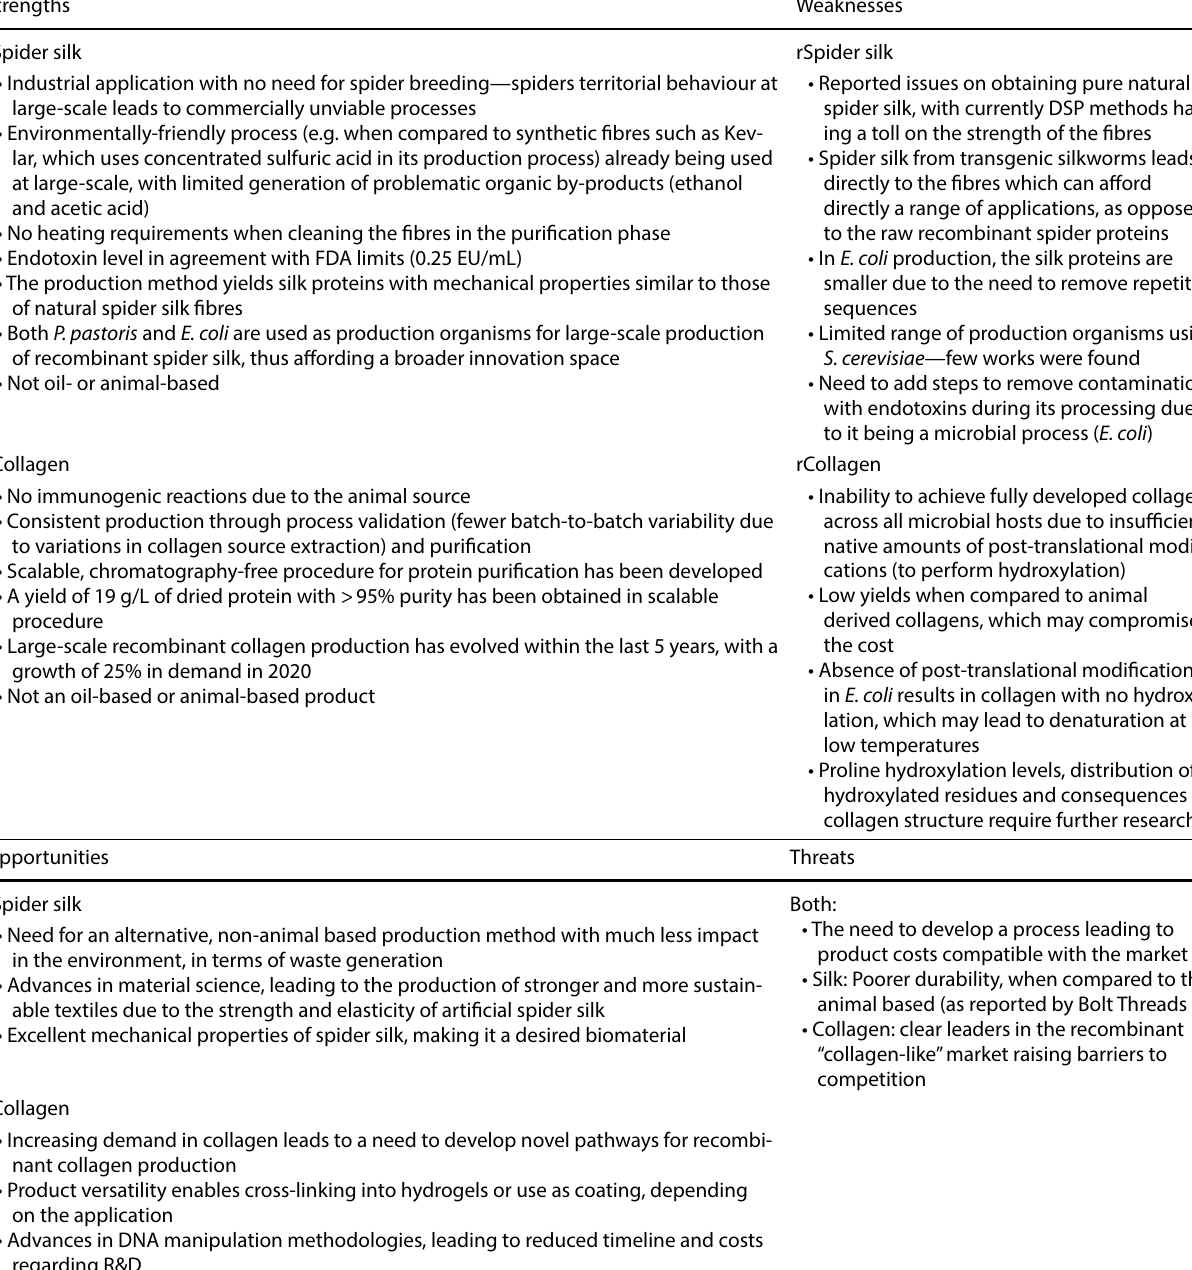
Table 4 Strengths, weaknesses, opportunities and threats (SWOT) matrix depicted for recombinant spider silk and collagen microbial pro- duction